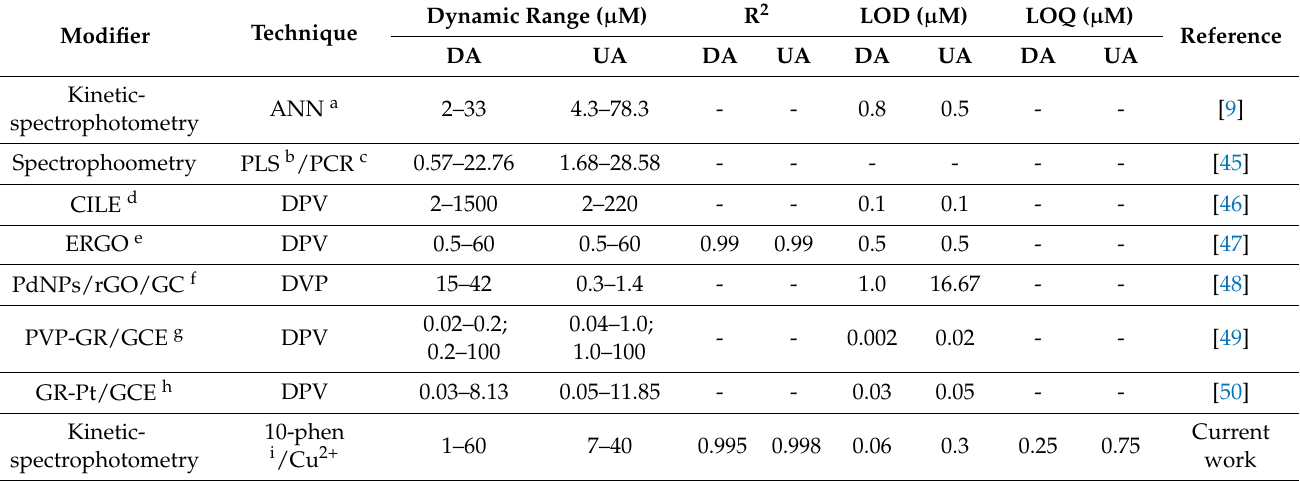
Table 5. Comparison of proposed method with some published